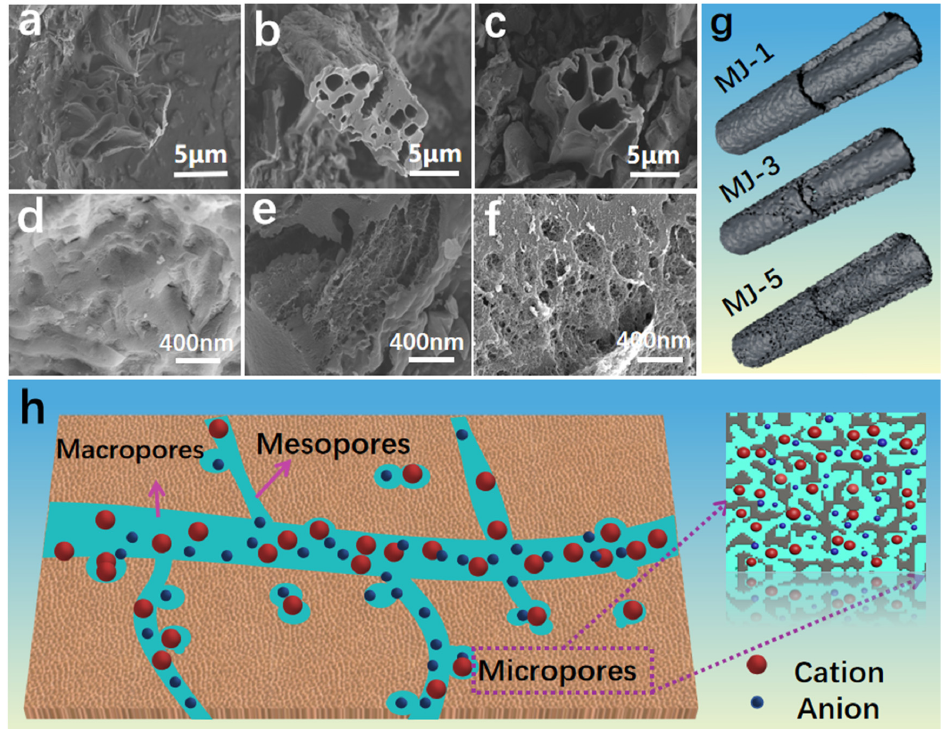
Figure 2. SEM images of activated carbon materials: ( a ) MJ − 1; ( b ) MJ − 3; ( c ) MJ − 5; Corresponding local magnification; ( d ) MJ − 1; ( e ) MJ − 3; ( f ) MJ − 5; ( g ) Structural schematic of MJ biomass-derived porous carbon; ( h ) Schematic illustration of ion transport in MJ − 5 hierarchical porous carbon. In order to further investigate the microstructure of MJ − x, the XRD, Raman, and XPS analyses were carried out, as shown in Figure 3. The two typical broad peaks at around 2 θ = 23.4° and 43.5° in Figure 3a are assigned to the (002) and (101) reflection peaks of amorphous carbon, implying that the MJ − x activated carbon possess a low degree of graphitization. The Raman spectroscopic response was conducted to analyze the MJ − x’s specific structure further, as shown in Figure 3b. Two distinct characteristic peak bands, after fitting, situated at around 1338 and 1596 cm − 1 are ascribed to the D band (defects and disorder) and G band (graphitic carbon), respectively. The intensity ratio of D and G (ID/IG) further expounds the graphitic and defective degree. A obtained high ID/IG value manifests more defects in the carbon products [40]. The ID/IG values of MJ − 1, MJ − 3, MJ − 5, and YP − 50 are 0.90, 0.92, 1.27, and 0.97, respectively, suggesting more defects being in- duced in the carbon with increasing KOH dosage, which is favorable for providing energy storage sites. To further explore the porosity of MJ − x products, the N 2 adsorption-desorp- tion isotherms and pore size distributions of all samples were conducted as shown in Fig- ure 3c,d. The isotherms of all samples displayed relatively high nitrogen uptake at low relative pressures, indicating the presence of a great number of micropores. Compared with MJ-1 and YP-50 samples, at moderate relative pressures (P/P 0 = 0.4–1.0), there is a clear hysteresis loop (IV-type isotherms) for MJ − 3 and MJ − 5, elucidating a great amount of mesopores generated. Moreover, a slight upward tendency at relatively high pressure (P/P 0 = 0.95–1.0) reveals the existence of macropores [41,42]. Furthermore, the pore size distribution as shown in Figure 3c obtained using DFT method mode also confirms that the as-is carbon covers micropores (<2 nm) and mesopores (2–6 nm). The calculated SSA of MJ − 5 based on the BET test is up to 3635 m 2 g − 1 , which is higher than YP-50 and most